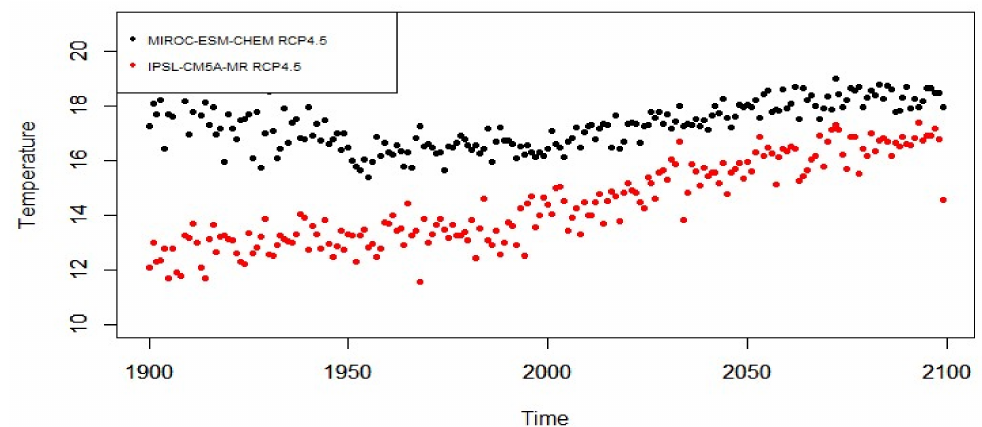
Figure 29. Representative Concentration Pathway (RCP) 4.5 hot model (MIROC-ESM-CHEM) and warm model (IPSL-CM5A-MR), temperature in ◦